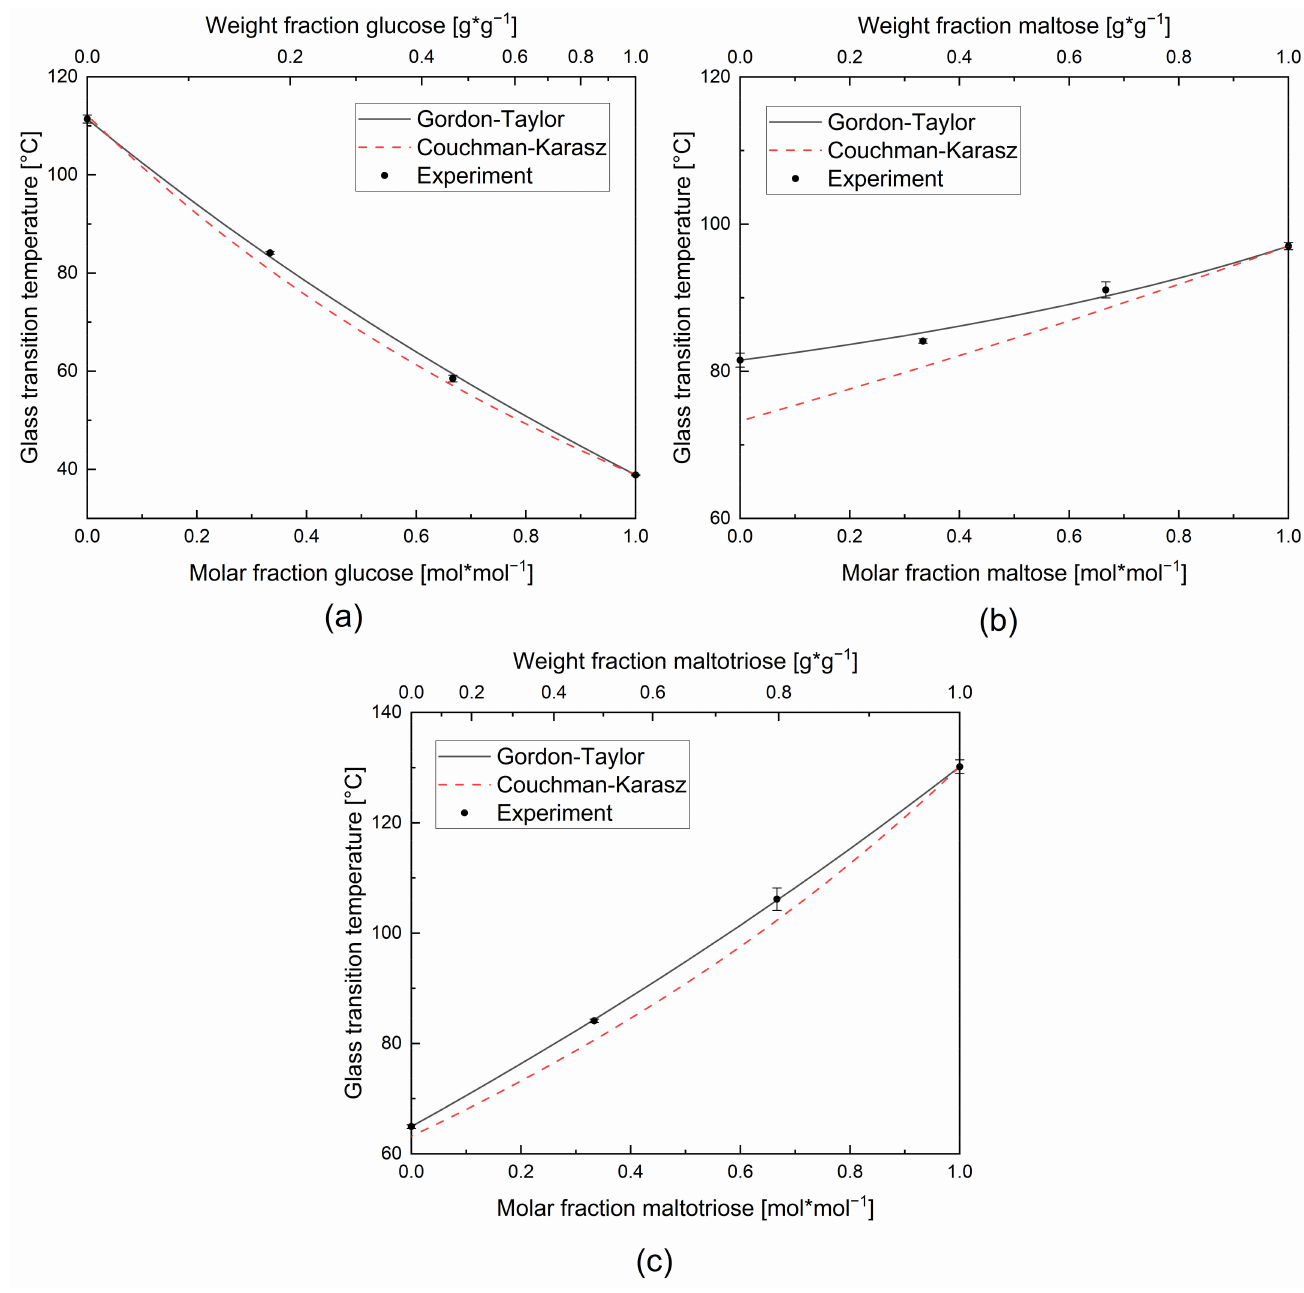
Figure 8. Experimental glass transition temperatures and glass transition temperatures according to the Gordon–Taylor and Couchman–Karasz equations of the ternary glucose–maltose–maltotriose mixtures as a function of molar fraction and weight fraction of the main sugar ( a ) glucose, ( b ) maltose, and ( c ) maltotriose (axis labels). As the proportion of the main sugar varies for each composition, the remaining sugars are mixed